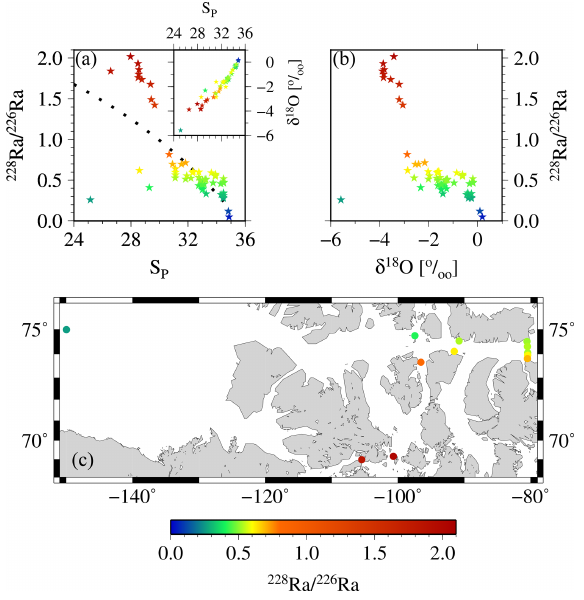
Figure 12. Relationship between 228 Ra / 226 Ra as derived from the apparent end-members vs. (a) salinity and (b) δ 18 O. The in- set in panel (a) shows the S P vs. δ 18 O relationship. Increasing fractions of sea ice would cause a near-horizontal shift in that re- lationship (sea-ice δ 18 O end-member = − 2‰), whereas meteoric water would cause a “diagonal” shift (meteoric water δ 18 O end- member = − 20‰); see also Thomas et al., 2011 for more details. In panel (c) 228 Ra / 226 Ra in surface samples across the CAA de- pict the different flow passes via the Northwest Passage and via McClure Strait, Parry Channel, and Lancaster Sound, respectively. For reasons of clarity, only the surface samples have been shown in panel (c) . The color coding groups the samples into water masses with high salinity and low isotopic ratio (ATL), with low salinity and high isotopic ratio (shelf waters near the 228 Ra source), and with low salinity and low isotopic ratio (waters in direction of CB4),